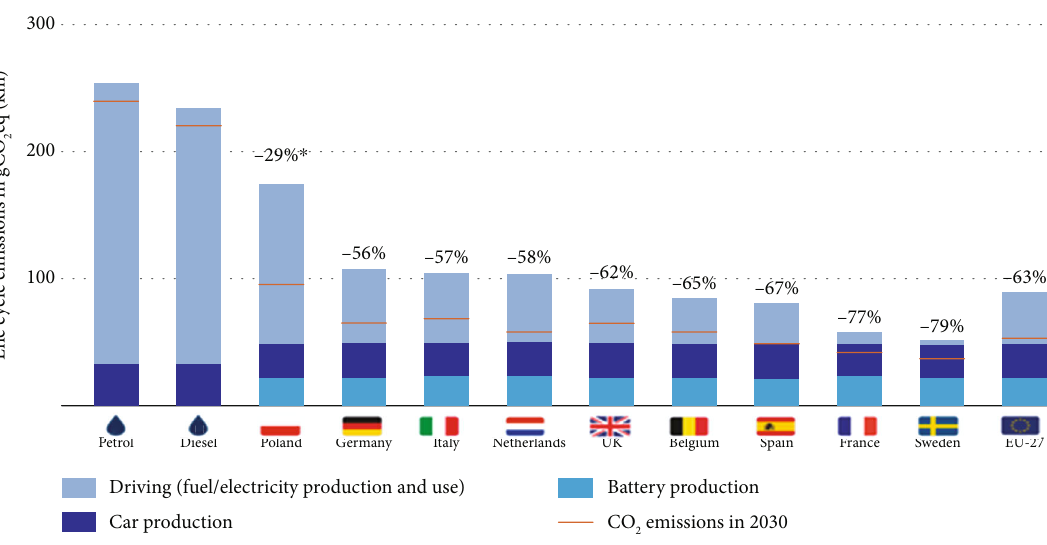
Figure 4: The carbon dioxide (CO ) savings in EVs compared to typical diesel and petrol car emissions [33, 34]. 2